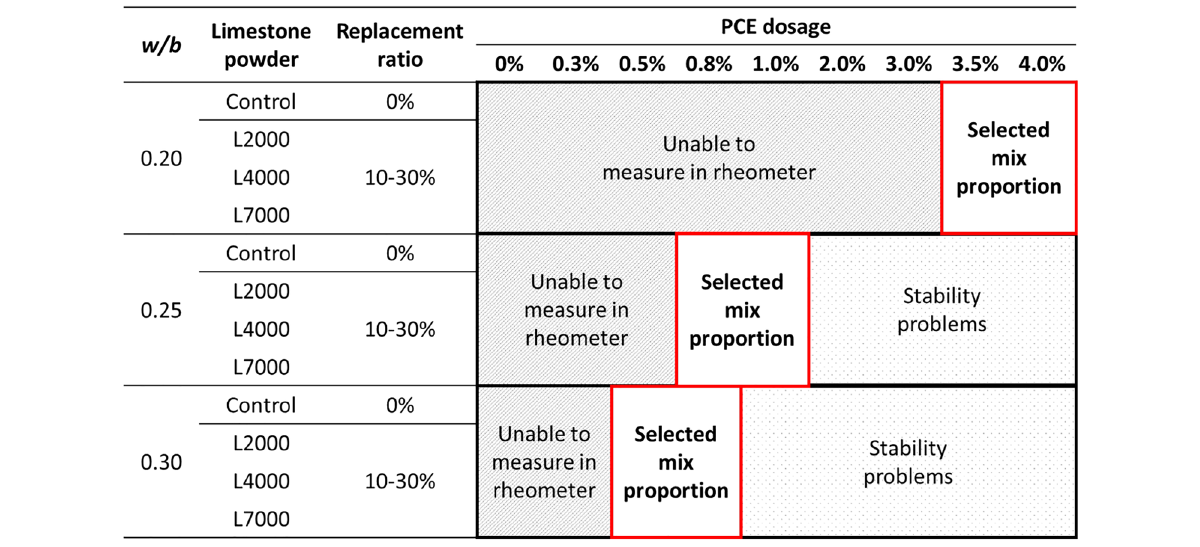
Fig. 3 Decision of acceptable SP dosage